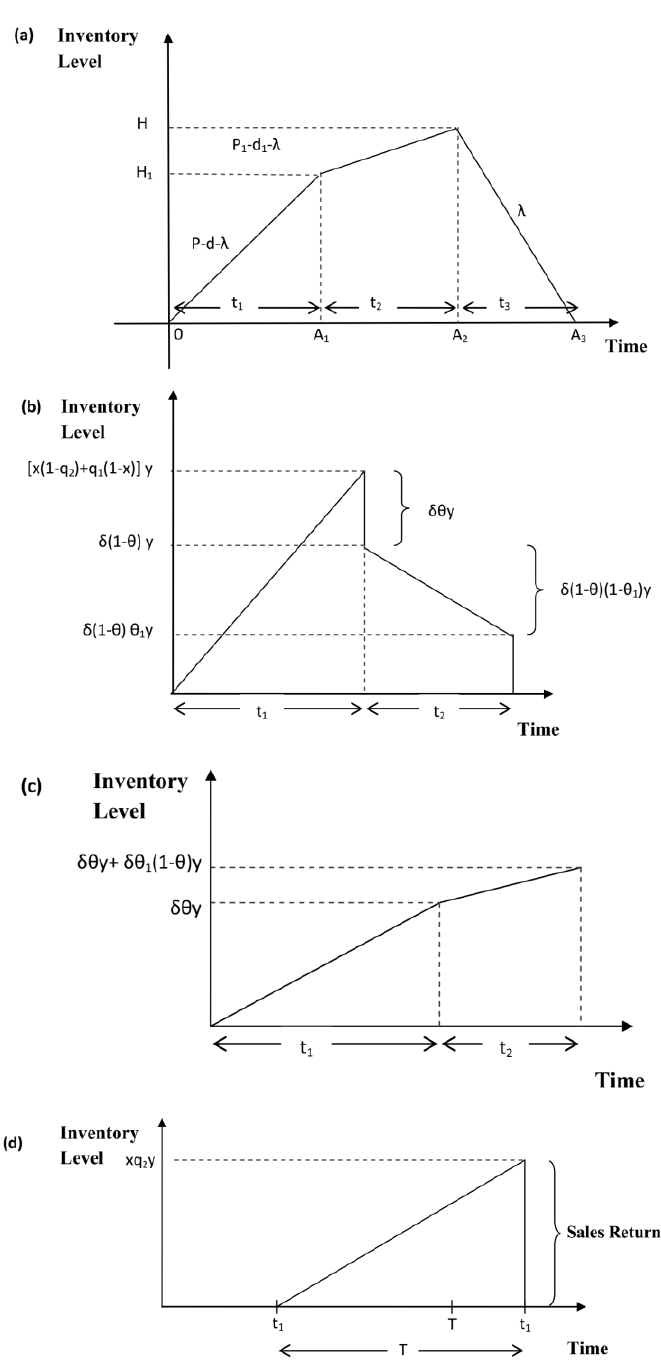
Fig. 2. Inventory behaviors of (a) imperfect production and inspection system, (b) defective items sorted through inspection process, (c) total scrap items (d) sales